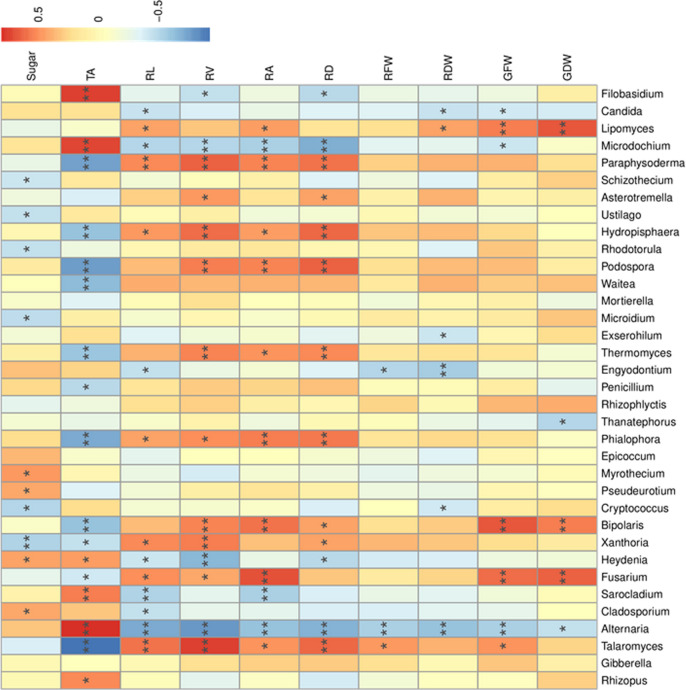
Spearman’s rank-correlations (r) between the top 35 most abundant fungal genera, oat morphologies, and root exudates where the “r” value is between −1 and 1.An r < 0 indicates a negative correlation and an r > 0 indicates a positive correlation. The labels *, ** and *** indicate significance levels of p < 0.05, p < 0.01 and p < 0.001, respectively. The following parameters were used: Sugar, soluble sugar; TA, total organic acid; RL, root length; RV, root volume; RA, root surface area; RD, root diameter; RFW, root fresh biomass; RDW, root dry biomass; GFW, shoot fresh biomass; and GDW, shoot dry biomass.